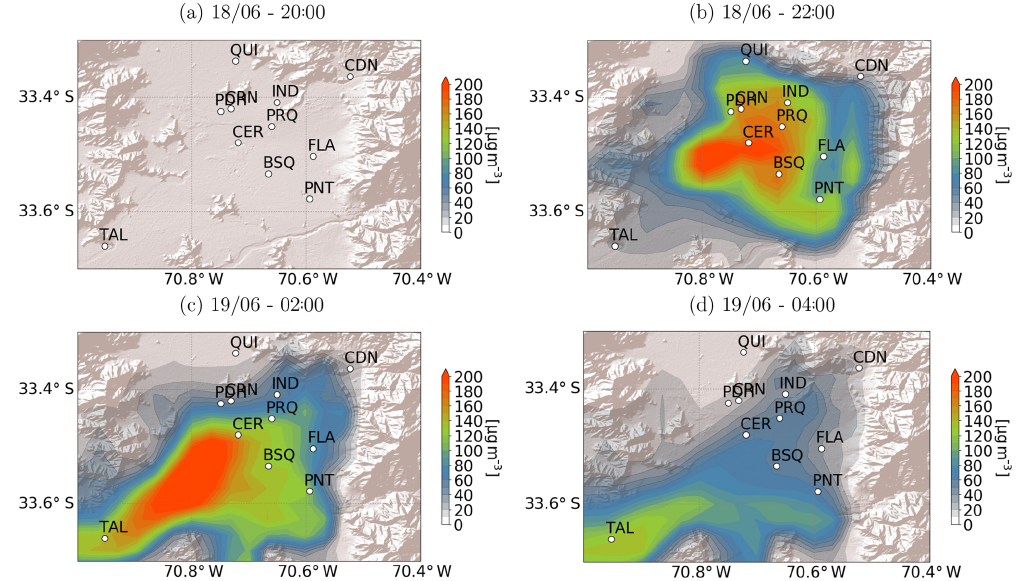
Figure 12. PM 2 . 5 concentration difference at 60m above the surface between the peak event and baseline simulation on 18–19 June. Positive values indicate excess concentrations in the peak event scenario compared to the baseline. Map background layer: World Shaded Relief, © 2009